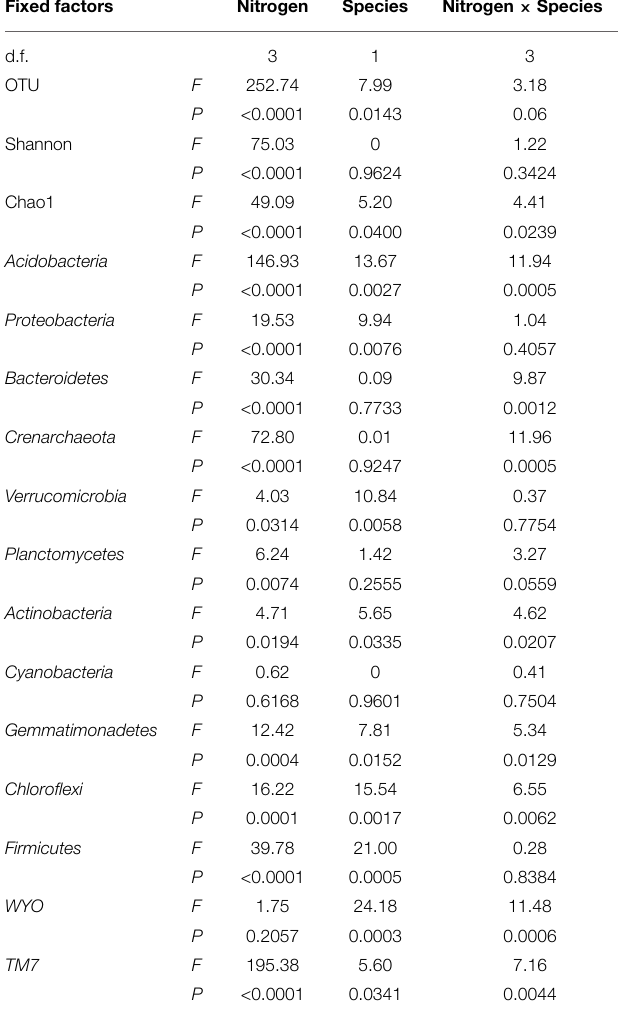
TABLE 1 | F-value and P -value of analysis of variance for the effects of nitrogen addition, species and their interaction (nitrogen × species) on OTU, Shannon, Chao1 indices and the relative abundance of the phyla.